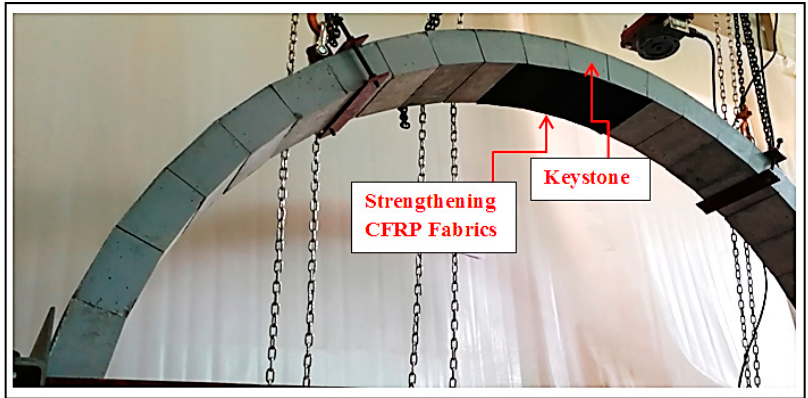
Figure 9. Strengthened self-form masonry arch F2-80-80-ST.